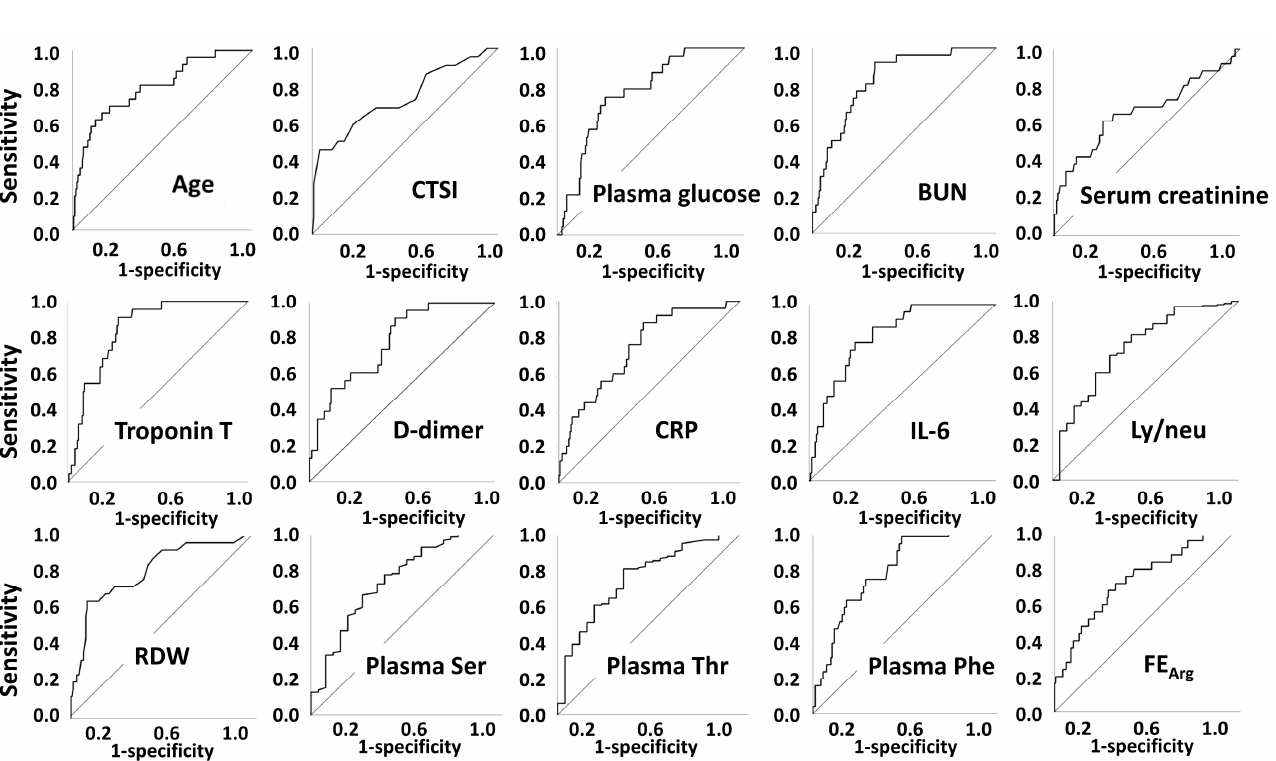
Table 2. Predictors of mortality.